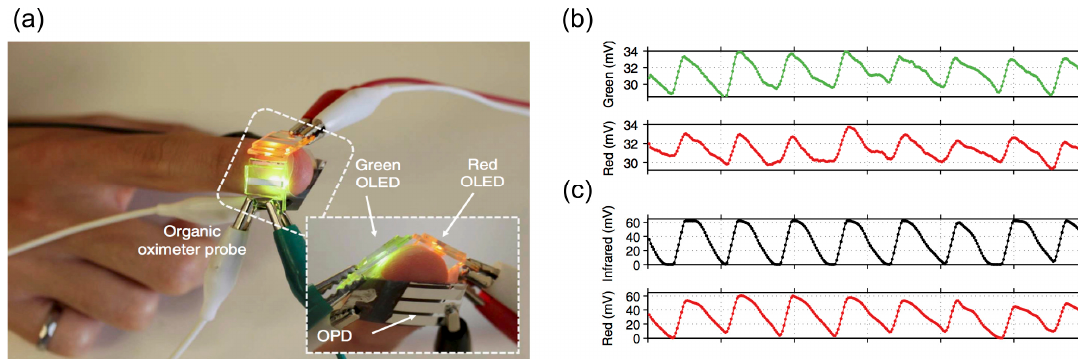
Figure 2. Flexible pulse oximeter device made from organic light-emitting diodes (OLEDs) and organic photodiode (OPD): ( a ) placement of red and green OLED on the subject finger with OPD placed on the opposite side; ( b ) heart rate detected by flexible setting; and ( c ) heart rate detected by conventional pulse oximeter device (Reprinted with permission [9]. Copyright 2014, Nature Publishing Group).